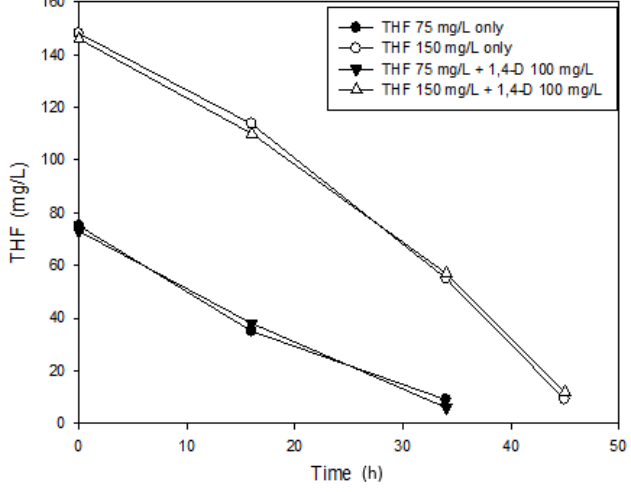
ff ect of 1,4-dioxane (1,4-D). Figure 10. The biodegradation of THF in effect of 1,4-dioxane (1,4-D). Figure 10. The biodegradation of THF in e Figure 10. The biodegradation of THF in effect of 1,4-dioxane (1,4-D). Table 4. Kinetic coe ffi cients of cometabolism 1,4-dioxane and THF as COD at di ff erent concentration of